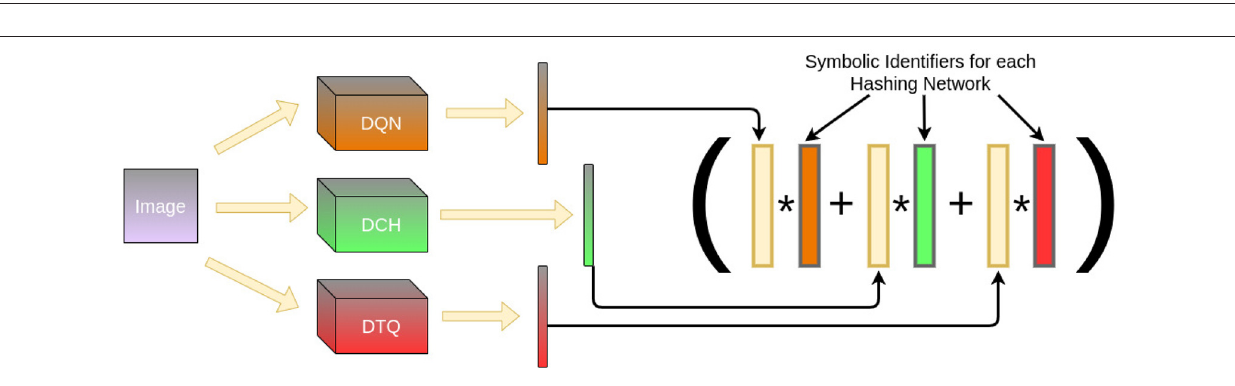
FIGURE 5 | Given multiple ML models, the HIL of each can be fused together by repeating the same training procedure. Thus, given an image, each hashing network converts it to a different binary vector, which is projected into hyperdimensional lengths. These are bound with symbolic vectors identifying each individual hashing network and aggregated via consensus sum. The result allows us to perform inference across multiple models at testing